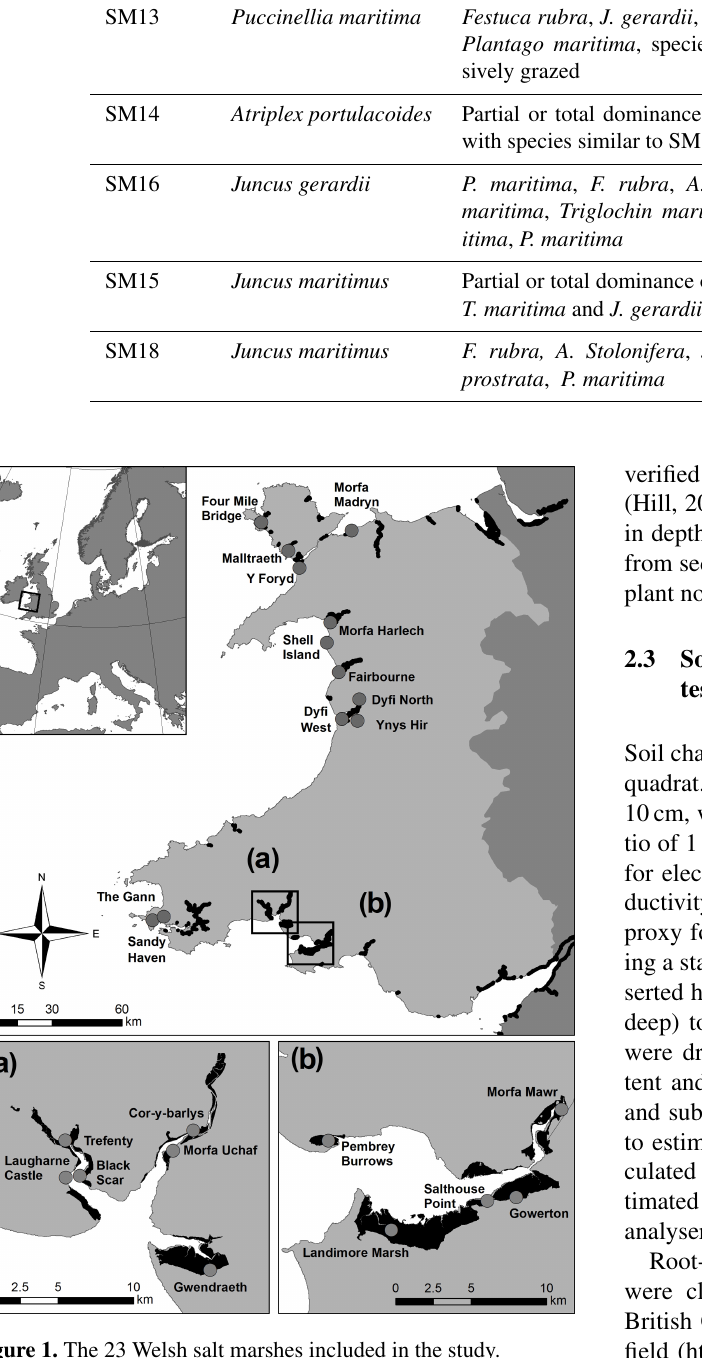
Figure 1. The 23 Welsh salt marshes included in the